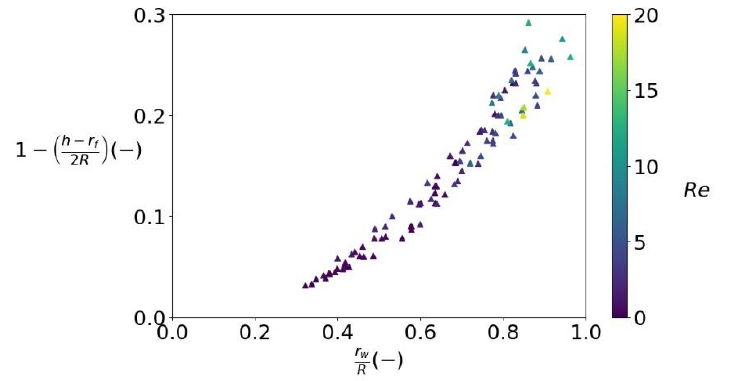
Figure 16. Normalized height of a deformed droplet as a function of the normalized wetting